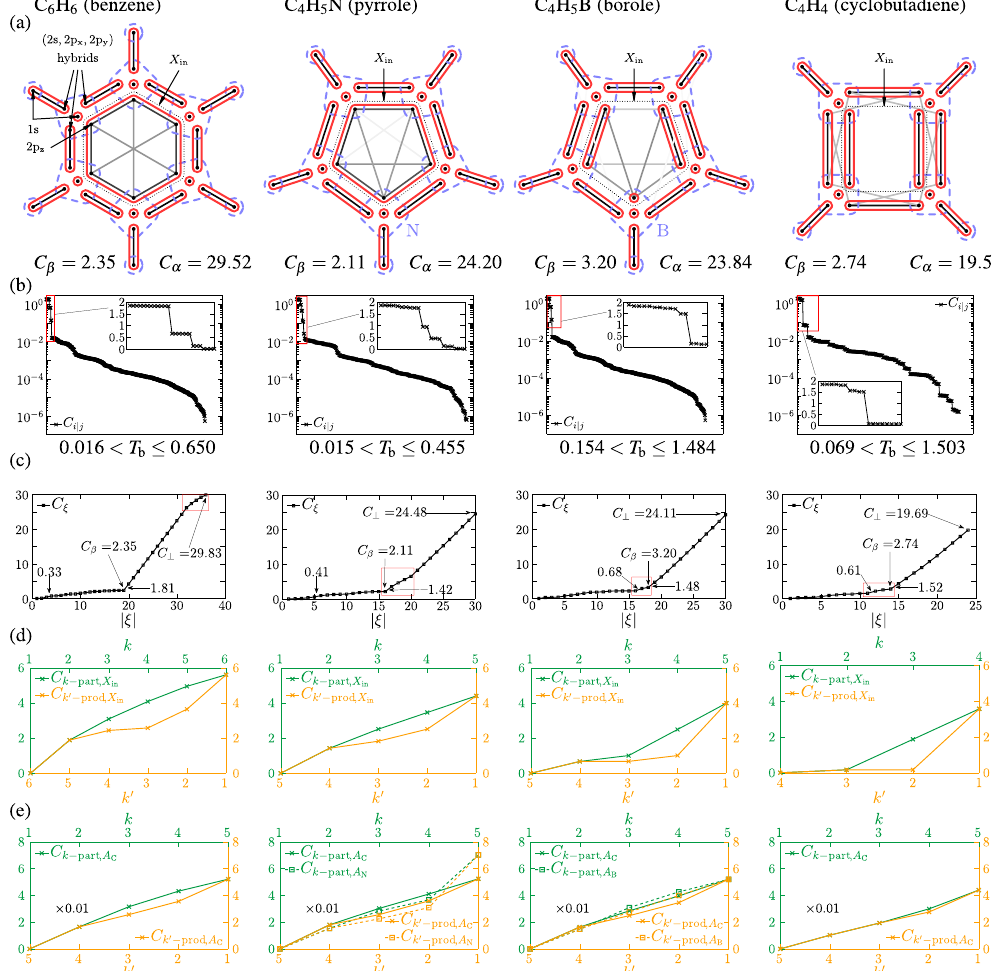
Figure 1. Partitioning and multipartite correlations for the benzene, pyrrole, borole and cyclobutadiene molecules. ( a ) Schematic view of the molecules: the dots represent atomic orbitals, the ones localised on an atom are encircled in dashed blue lines, this is the atomic split α , the ones strongly correlated with each other are encircled in solid red lines, this is the bond split β . Strength of edges represent two-orbital correlations (shaded by a logarithmic scale). The correlations C α and C β are also shown. ( b ) The distributions of the two- orbital correlations. The possible ranges of two-orbital correlation thresholds T b are also shown. ( c ) The C ξ tendencies of the successive bipartitioning. The humps arising from the bipartitioning of multiorbital correlated clusters are indicated with red frames. The maximal step before β and the minimal step following β are also shown. ( d ) The correlations − C , − C for the inner bonding (2p z ) orbitals, contained in X in . ( e ) The k X part, in k X prod, in correlations C k -prod, A , C k-part, A for selected atoms A. (The numerical values of the correlation measures are given in units of